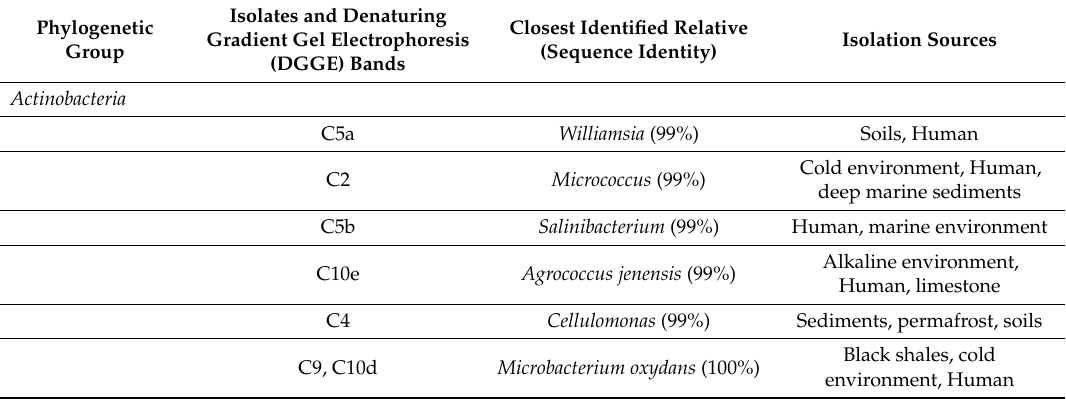
Table 3. Distribution of contaminant phylotypes that were identified within control